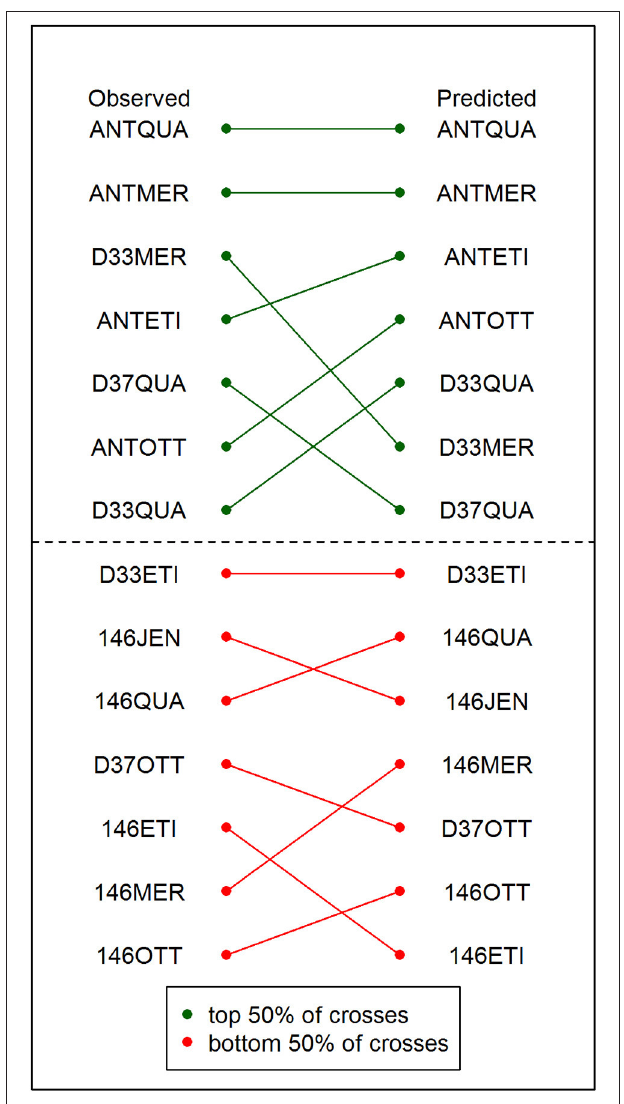
FIGURE 3 | Comparison of the observed and the predicted ranking of crosses. The observed ranking is based on the yields of the best DH lines resulting from each cross in the field trial ( left ). The predicted ranking of crosses is based on the criterion ˆ µ g + ˆ σ g from the predicted cross parameters ( right ). The 50% top-ranked crosses are depicted in green. The 50% bottom-ranked crosses are depicted in red. The green and red lines indicate how the position of the crosses has changed between the observed and the predicted ranking.